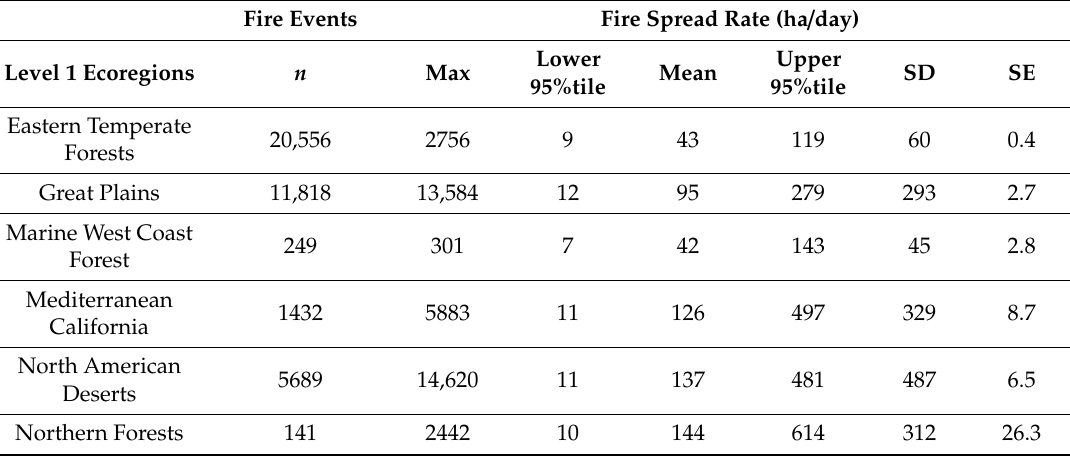
Table 7. Summary statistics of daily fire spread rate by level 1 ecoregion. Fire